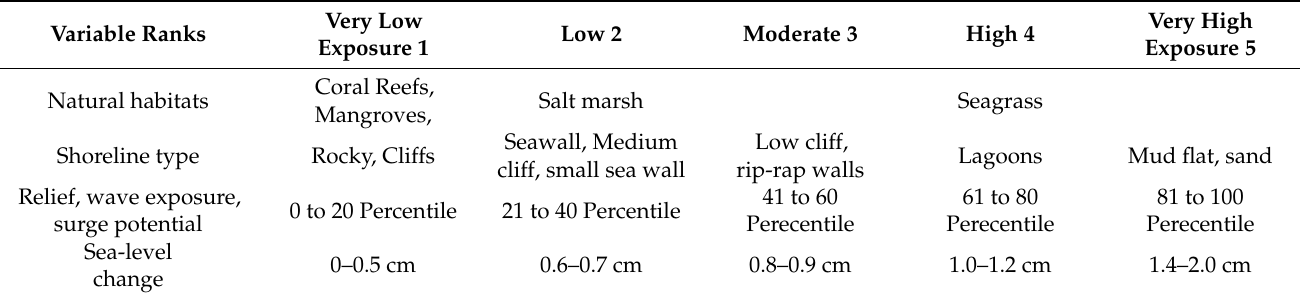
Table 1. Index of coastal hazard variables and